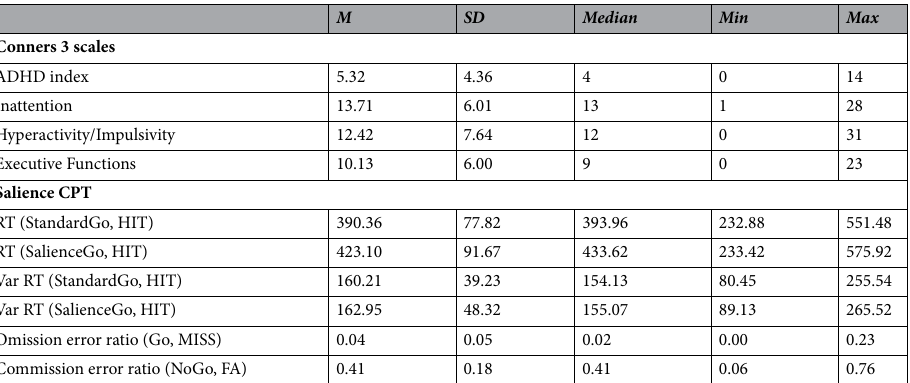
Table 1. Descriptive statistics of the Conners 3 scales and behavioral performance in the Salience Continuous Performance Task (Salience CPT). RT, mean reaction time (in ms) across all trials of a condition; Var RT, intra-subject variability (standard deviation) in reaction times (in ms) across all trials of a condition; M , mean (across subjects); SD , standard deviation (across subjects); Min , minimum value observed across all participants; Max , maximum value observed across all participants.